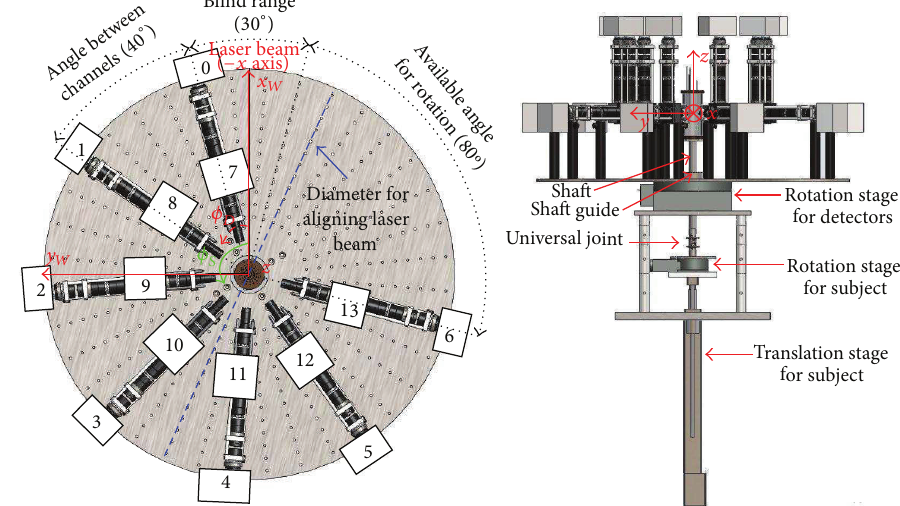
Figure 7: First-generation scanner. Drawings of top and side